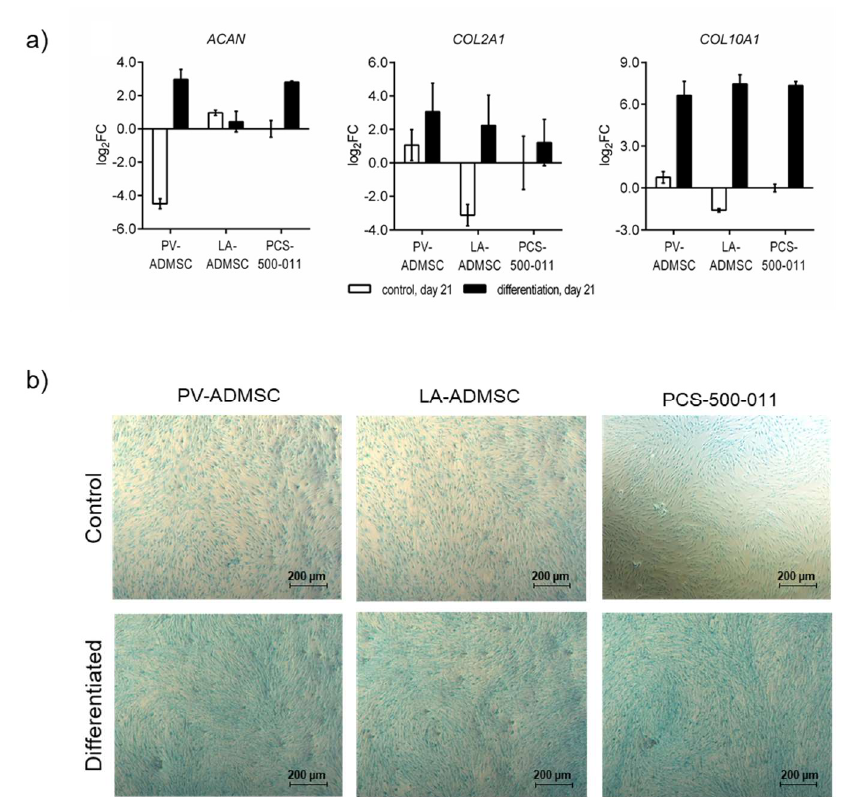
Figure 6. Chondrogenic differentiation of human ADMSCs. ( a ) The mRNA expression of ACAN , COL2A1 and COL10A1 in human ADMSCs after 21 days of differentiation. The results are normalized to the control (undifferentiated) PCS-500-011 cells on day 21 ( n = 2). ( b ) Furthermore, after 21 days of incubation in either standard (upper panel) or differentiation medium (lower panel), cells were fixed and stained with Alcian Blue staining solution for glycosaminoglycans.